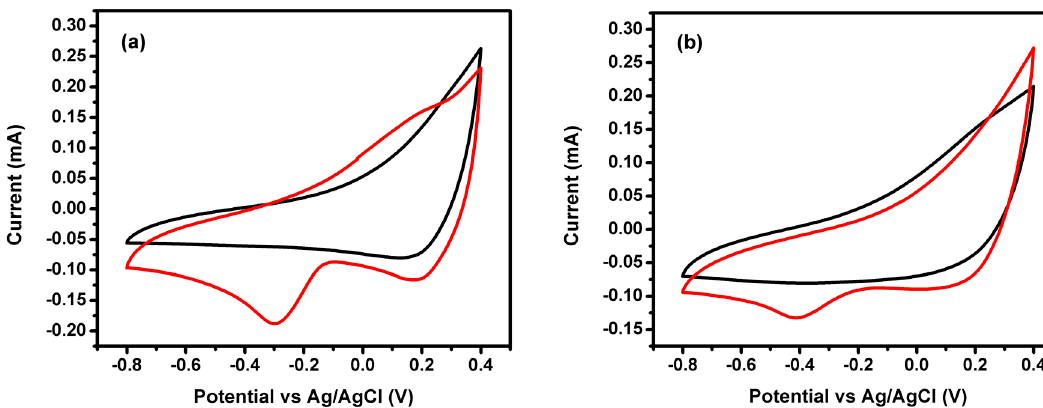
Figure 6. Cyclic voltammograms (CV) of ( a ) NiCo 2 O 4 /Co-CX in both nitrogen (black) and oxygen (red) saturated electrolyte and ( b ) NiCo 2 O 4 /Ni-CX in both nitrogen (black) and oxygen (red) saturated electrolyte.